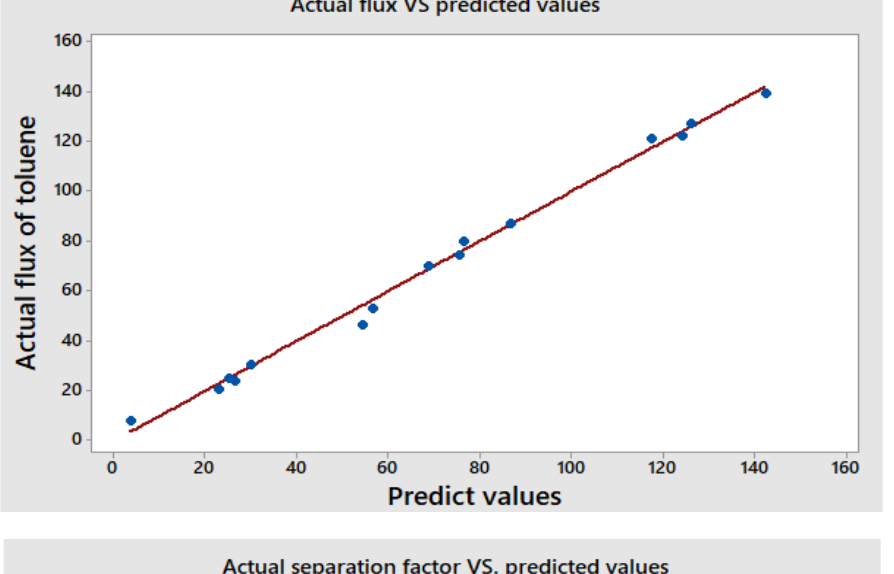
Table 2. The coefficients in Equations (4) and (5).